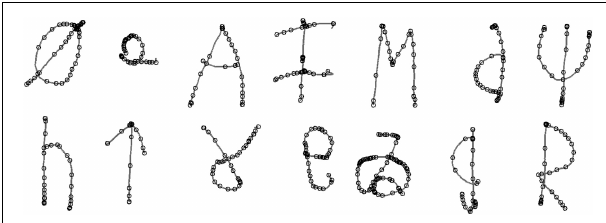
FIGURE 2 | Example output from the character copying task, produced by a child with relatively disfluent handwriting. Small circles represent the location in the pen trace of a velocity peak, after 10 Hz